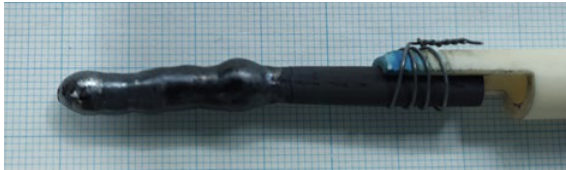
Figure 2. A picture of the FeCr 2 O 4 crystal grown by the optical floating zone method (see text). XRD measurements were carried out with the Bruker D8 Advance